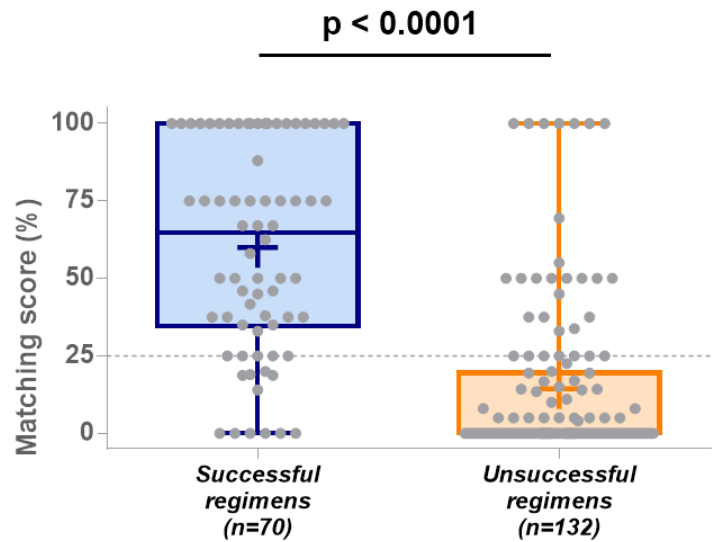
Figure 4. Matching score distribution between successful and unsuccessful regimens. Each regimen is represented by a grey dot; median, minimum and maximum scores are represented by a blue (for successful outcomes) or an orange (for unsuccessful outcomes) boxplot; average scores for both groups are indicated by a “+”. Abbreviation : n = number; p = p -value.